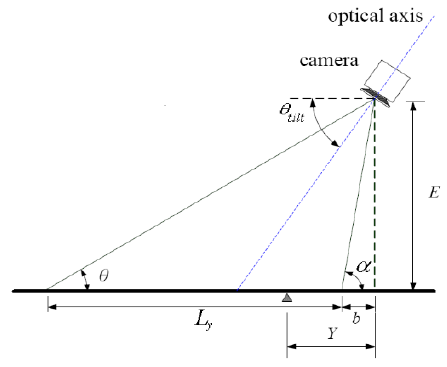
Figure 3. Side view of camera [17].